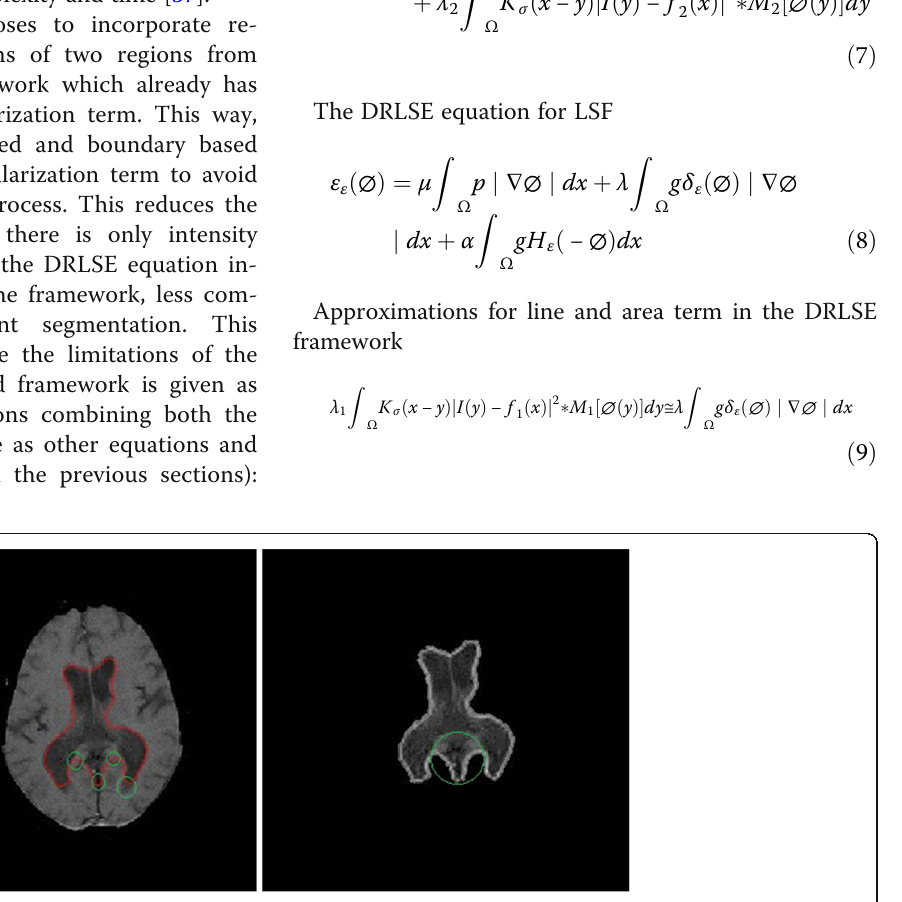
Fig. 3 Resultant images of segmentation using the conventional DRLSE method with optimized parameters. Without the regional information, the DRLSE framework fails to converge to the actual